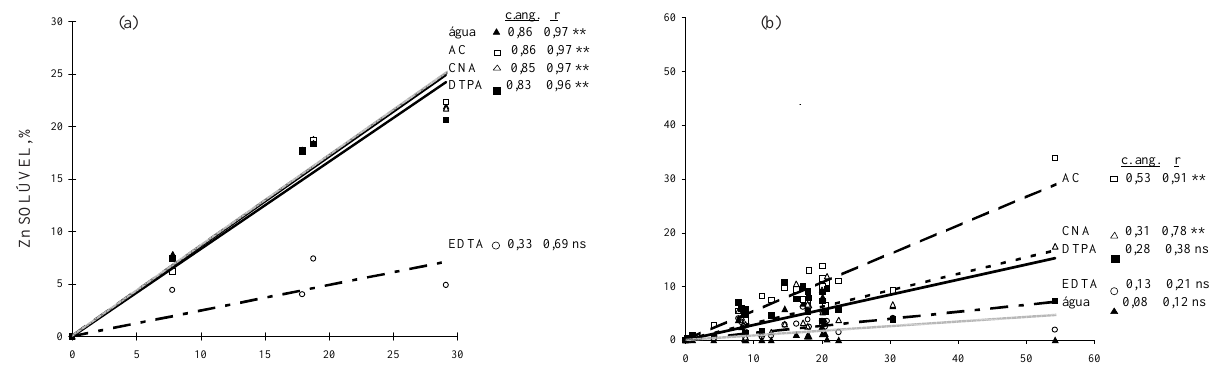
Figura 1. Solubilidade do zinco presente em fertilizantes comerciais solúveis (a) e insolúveis em água (b), nos diversos extratores utilizados, e respectivos coeficientes angulares das retas (c.ang.) e coeficientes de correlação (r). ** e ns significativo a 1% e não-significativo,